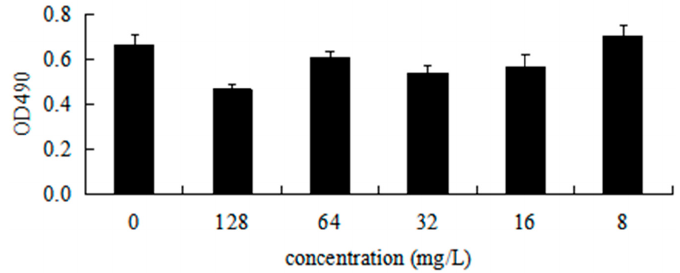
Figure 8. Effect of DHA27 at different concentrations on the growth of mouse macrophages RAW264.7. RAW264.7 cells of logarithmic phase were adjusted to the concentration of 8 × 10 4 cells per milliliter with the DMEM (10% FBS) culture. The cells were placed on a 96-well plate (180 µ L/well) and cultivated at 37 ◦ C, 5% CO 2 incubator for 24 h. DHA27 (20 µ L/well) was added to achieve the final concentrations of 128, 64, 32, 16, and 8 mg/L. The blank culture was set up for control and then the template was put at 37 ◦ C, 5% CO 2 incubator for 24 h. Mixed 100 µ L of low-glucose DMEM and 20 µ